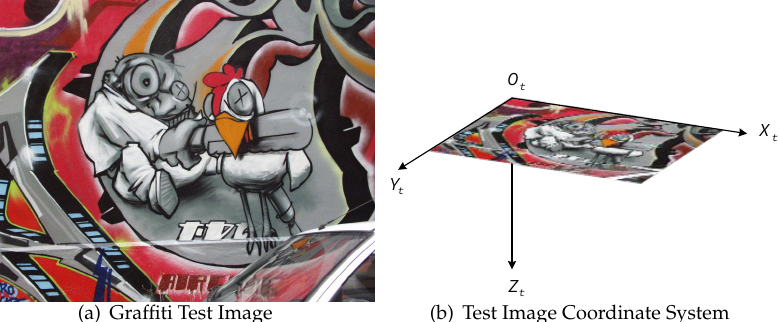
Figure A1. Graffiti Test Image ( a ) and the Test Image Coordinate System ( b ). The X -axis represents the row of the image pixel, the Y -axis represents the column of the image pixel, and the Z -axis is determined according to the right-hand